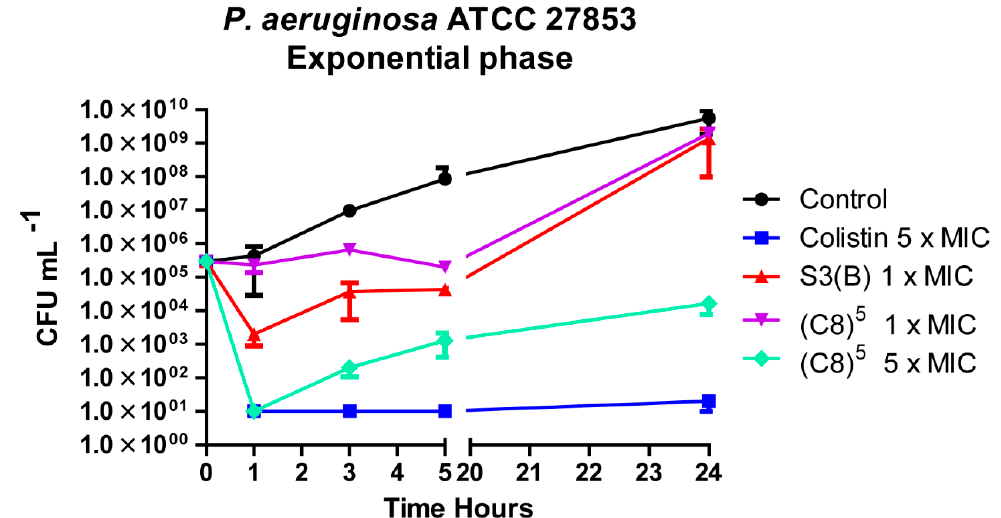
Figure 4. Time-kill curves for (C 8 ) 5 against P. aeruginosa at different concentrations; 1 × MIC and 5 × MIC. Data obtained for S3(B) and colistin are included as controls. The results are presented as mean ± standard deviations ( n = 3).